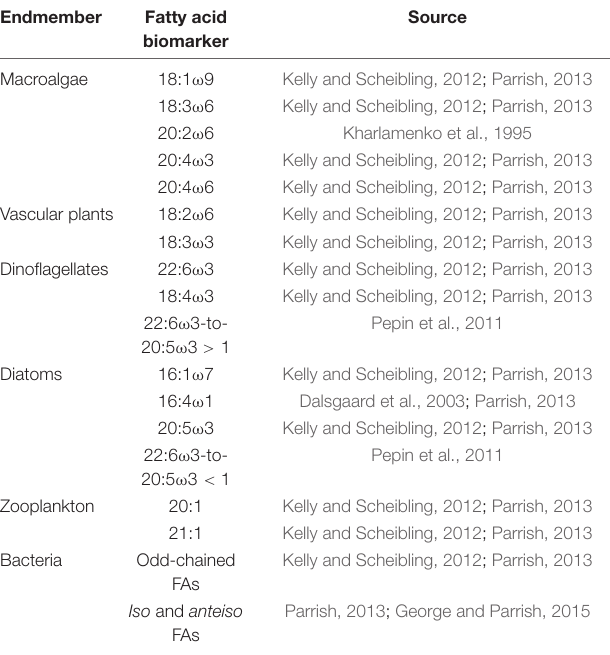
TABLE 1 | Fatty acid biomarkers used for each endmember in this study along with literature source of previous